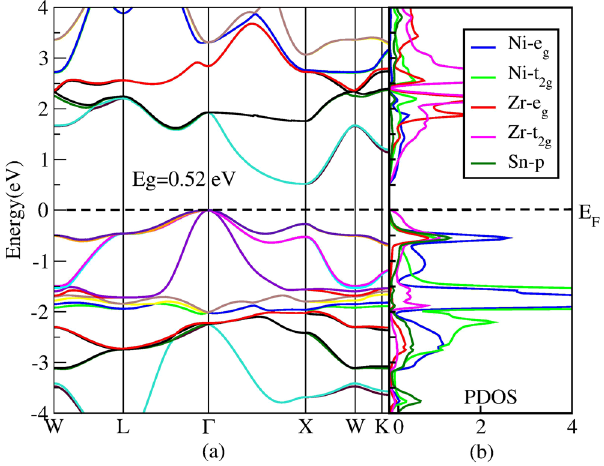
Figure 3. ( a ) Band structure of ZrNiSn. ( b ) Projected PDOS of